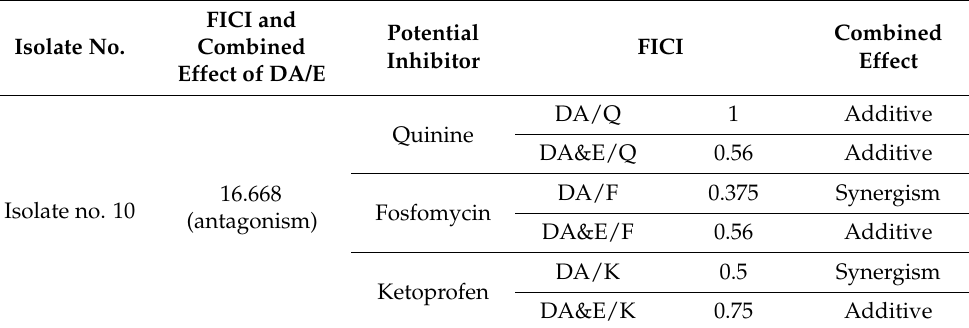
Table 5. Combined effect of clindamycin/erythromycin/potential inhibitors on S. aureus isolate no. 10 (D phenotype) using checkerboard assay. FICI and Isolate No.